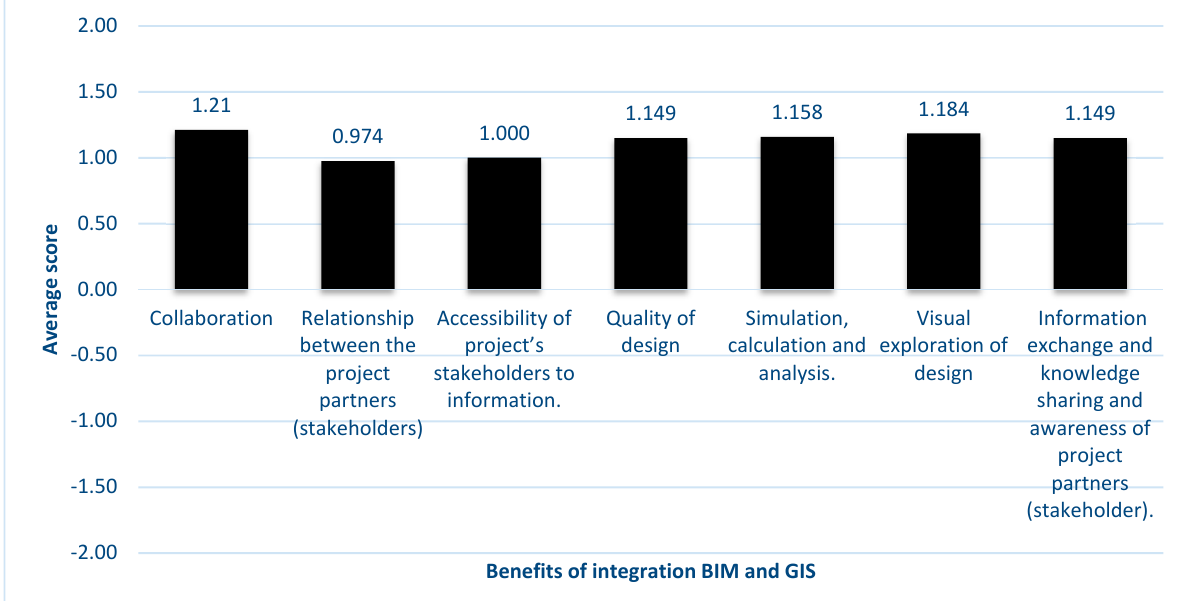
Figure 7. Benefits of Integration BIM and GIS in Design Stage.